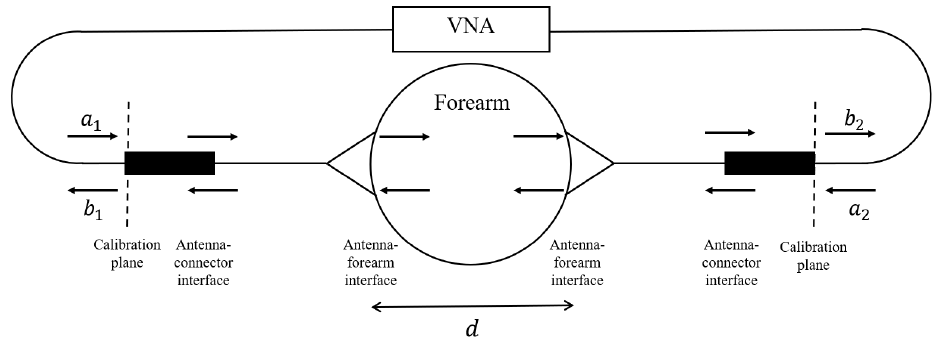
Figure 2. Schematic of measurement system with input waves a j and output waves b i